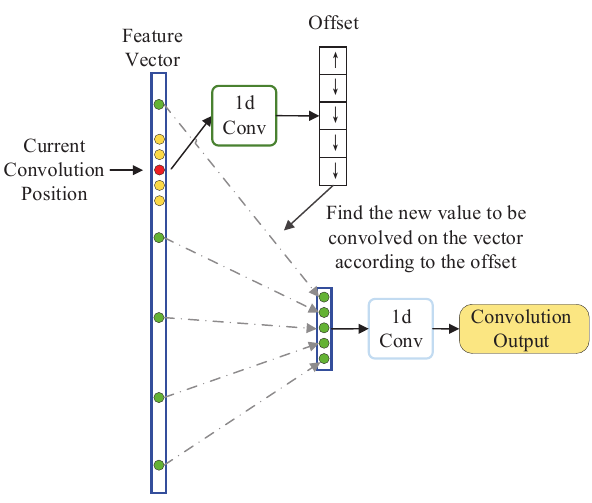
Figure 6. Non-local one-dimensional convolution structure